Question: Write the caption for this figure.
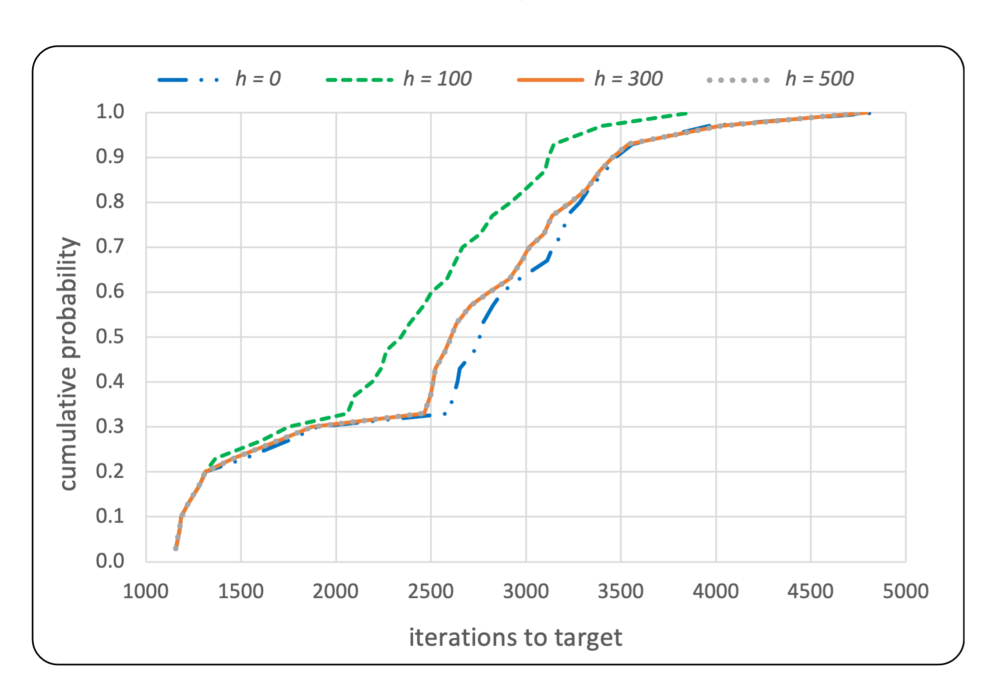
Answer: Run time distribution for analyzing of the restart parameter h: Large class